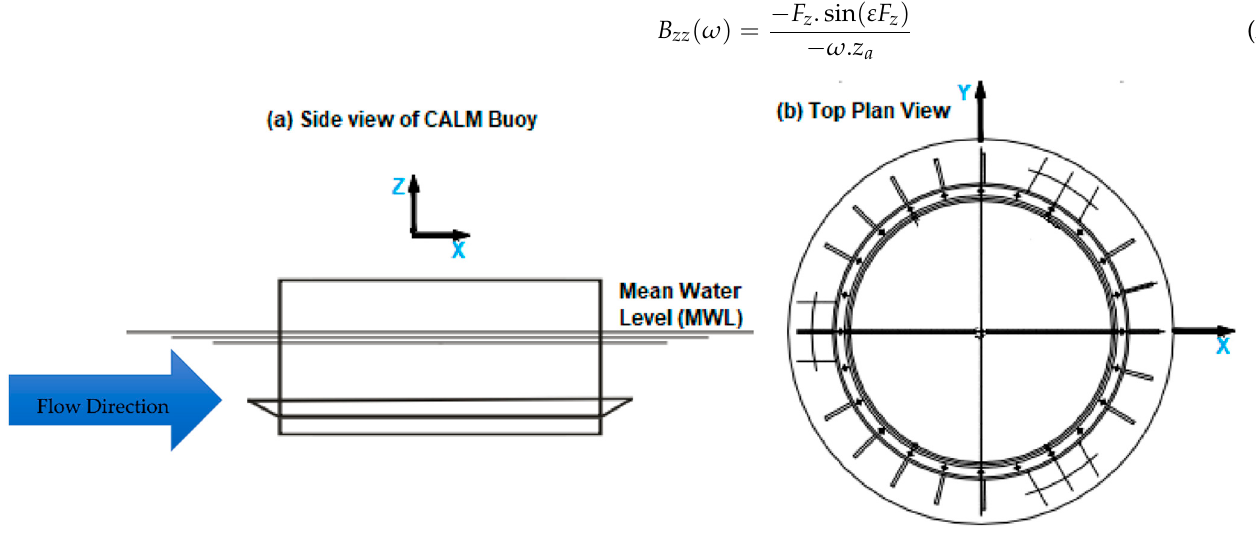
Figure 4. Definition sketch for the Coordinate System of CALM buoy Model (not drawn to scale).